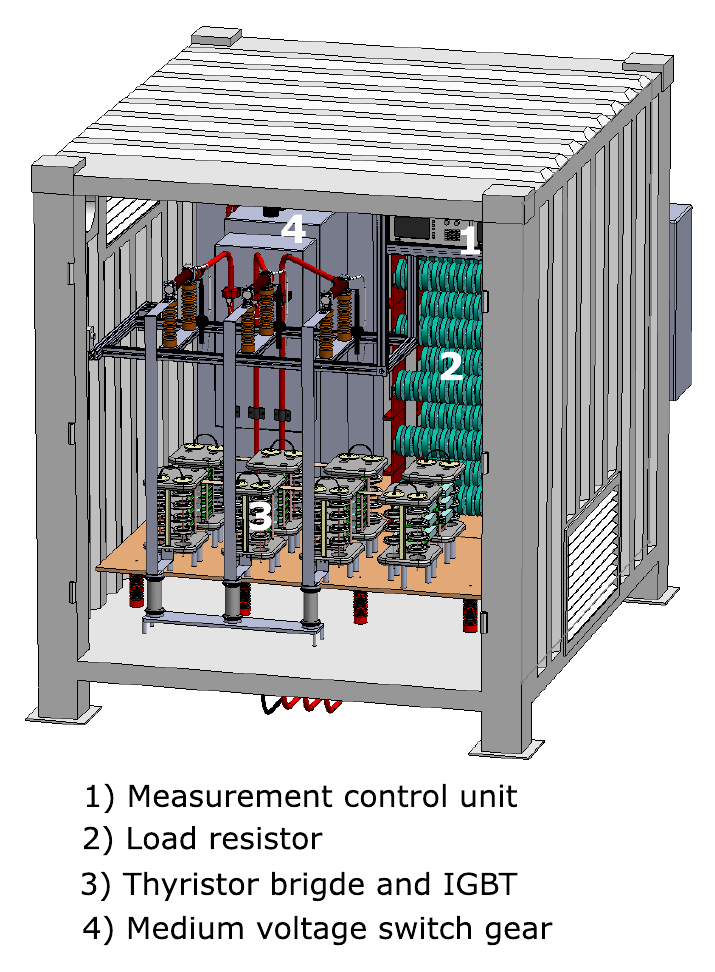
Figure 3. Impedance identification measurement device for 20 kV medium voltage